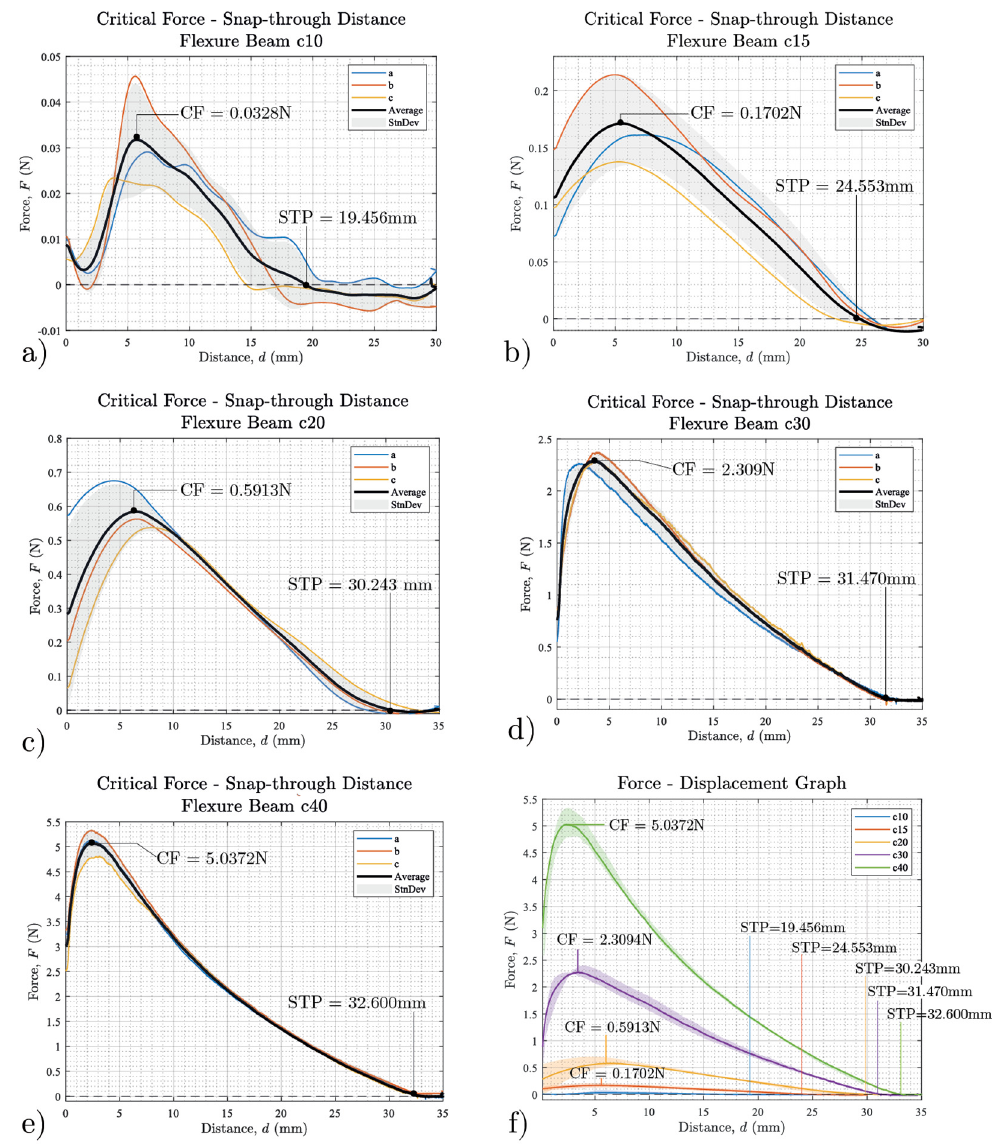
Figure 5. ( a – e ) Force-Displacement graph per thickness (c10 to c40), which represents the first part of the bi-stable curve. Three samples of each thickness were tested and are plotted in the graphs as a,b, c. The thicker black line plots the mean of the three sets of data. The standard deviation appears in light gray. ( f ) Force-Displacement graph comparing the mean curves of the five tested thicknesses. As the thickness increases, so do the critical force and the snap-through point.